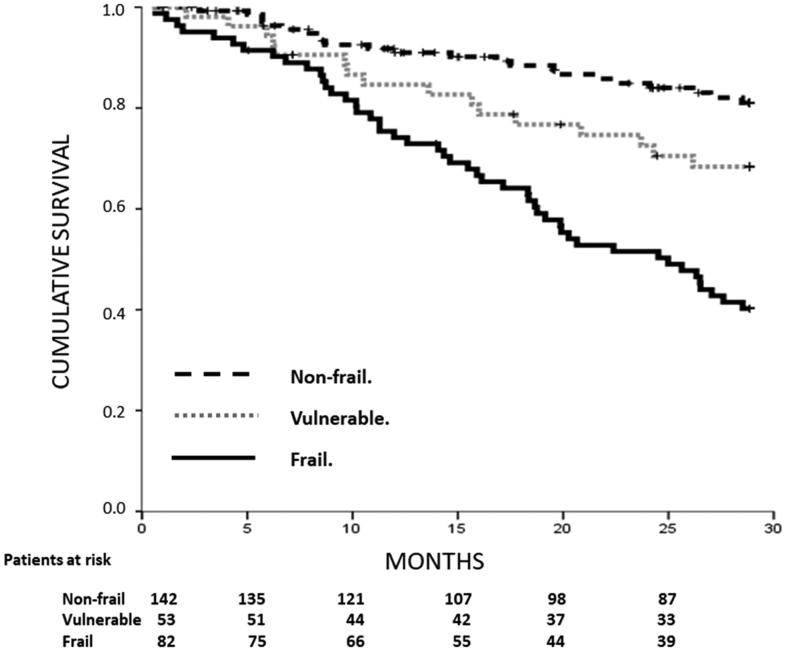
Kaplan–Meier survival curves by frailty status. Log-Rank test p values <.001.